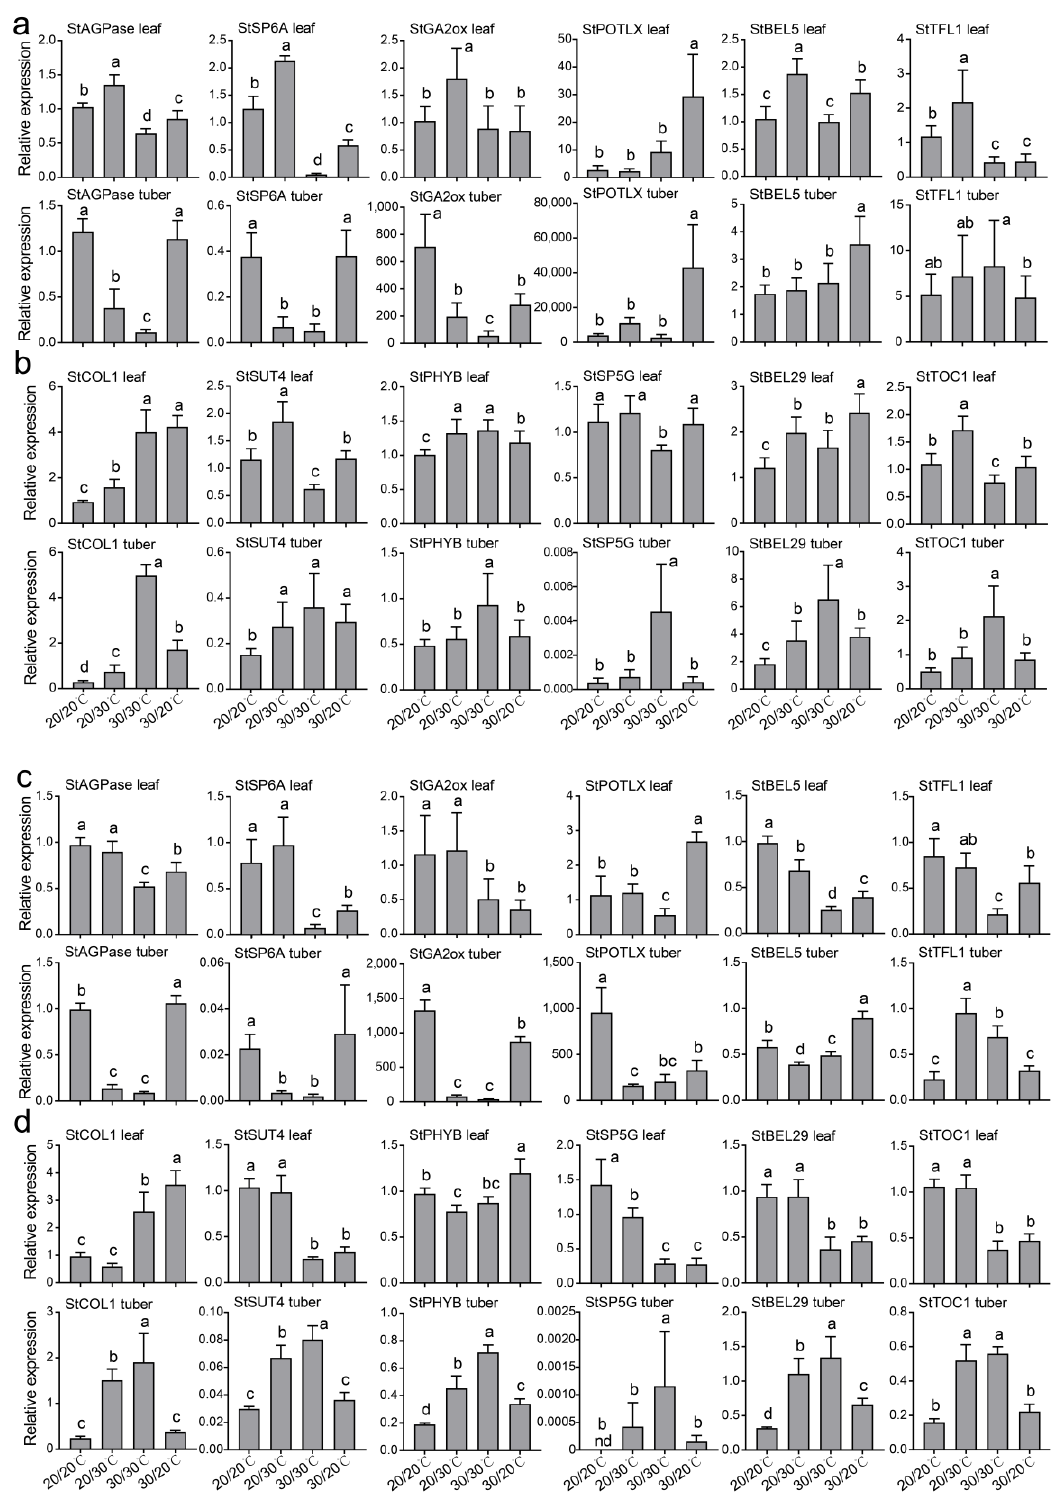
Figure 8. The expression of selected genes from the Qs9 ( a , b ) and D187 ( c , d ) plants under the heat- stress treatment of different plant parts was determined by RT – qPCR. Activator ( a , c ) and repressor ( b , d ) genes of tuberization. Three replicates were averaged and statistically analysed. The different lowercase letters indicate groups that are significantly different from one another.